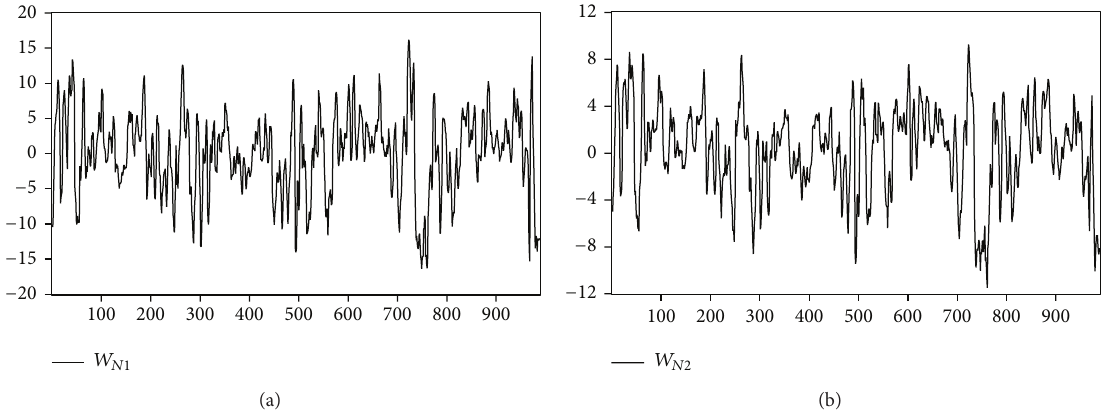
Figure 2: Temperature shock variable for natural gas.